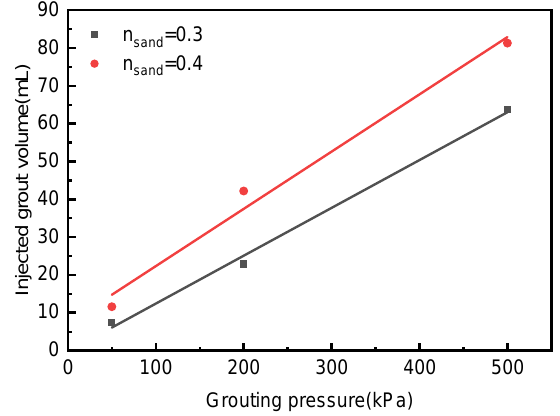
Figure 13. The volume of the grout bulb.